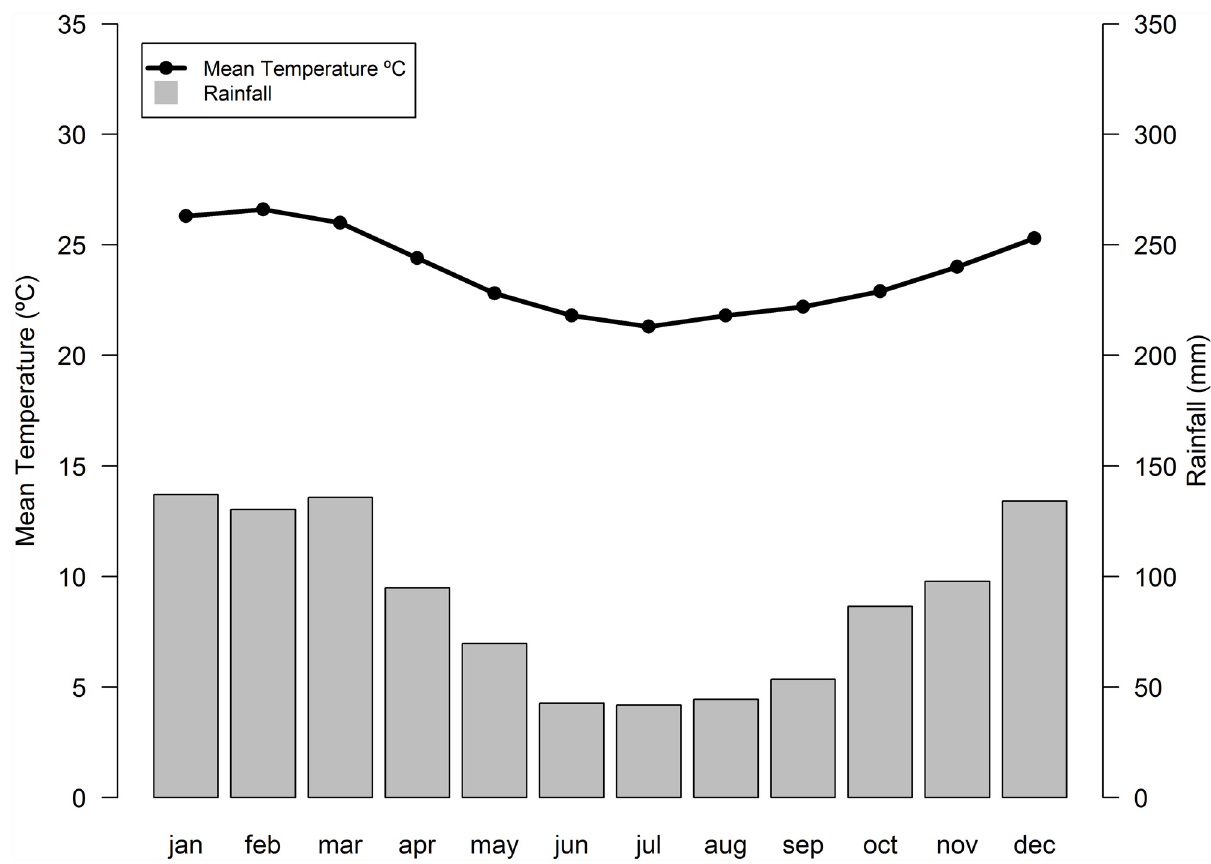
Fig 1. Climate normals (1961 – 1990) for the city of Rio de Janeiro. Instituto Nacional de Meteorologia — Brazilian National Institute of Meteorology, available at http://www.inmet.gov.br/.